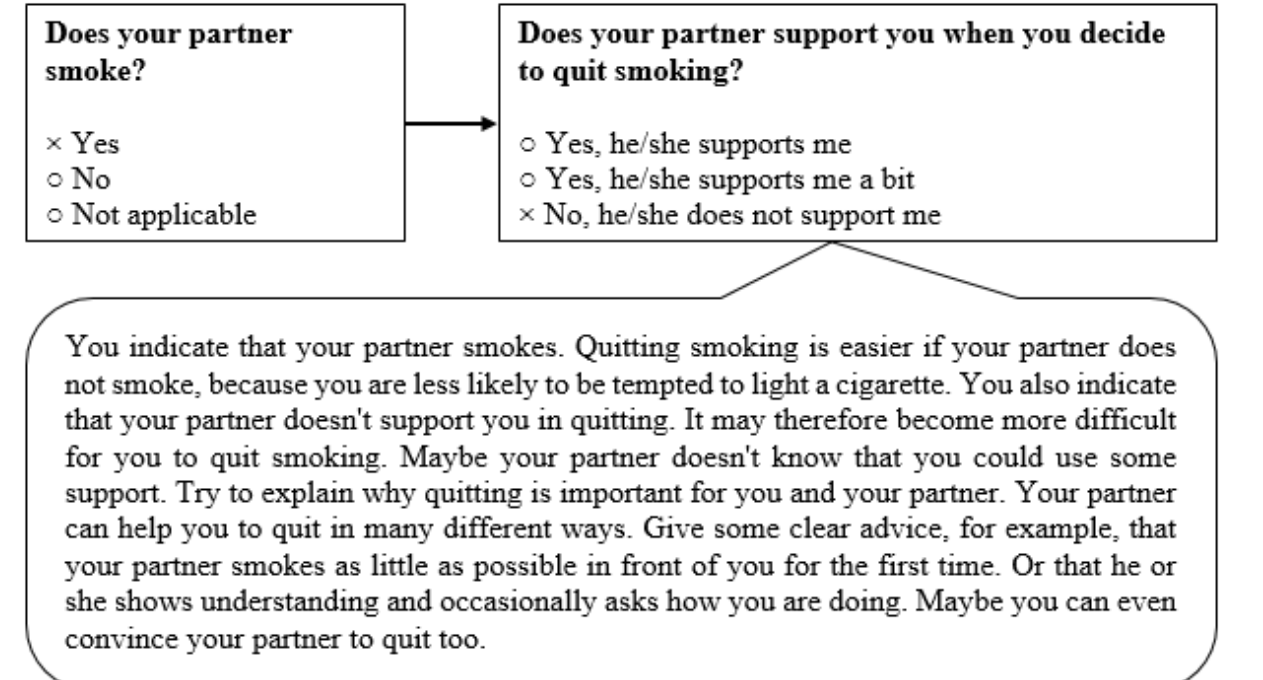
Figure 3. An example of tailored advice about the social influence of the